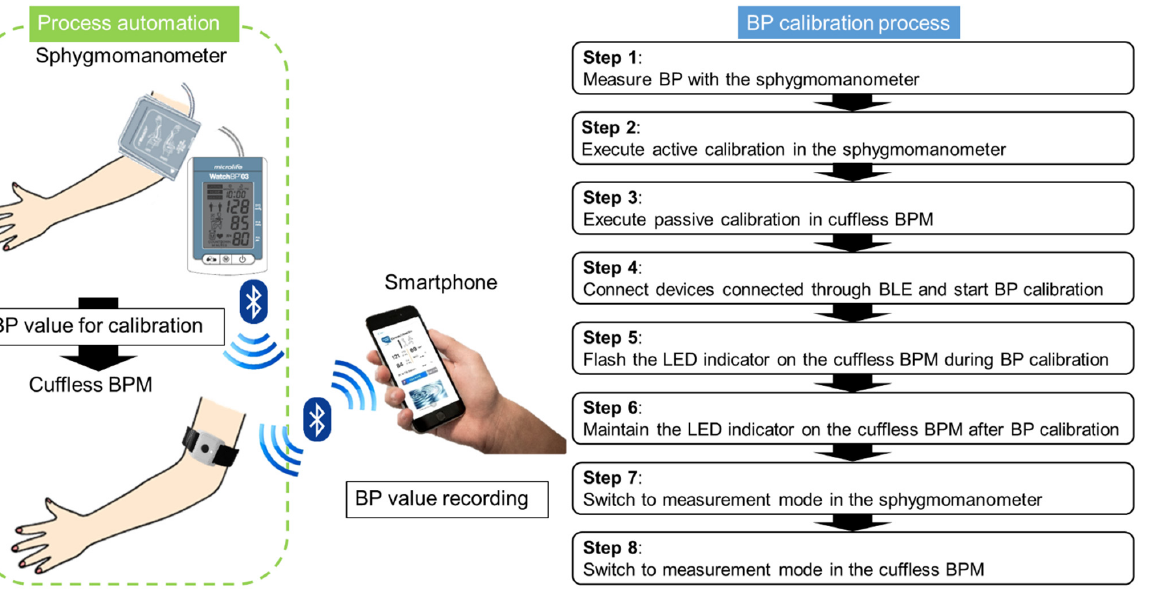
Figure 3. Autocalibration process for the cuffless BP measurement via a cuff-based (sphygmomanometer) monitor. To take the cuffless BP measurement the first time, a user starts to operate a BP cuff with a sphygmomanometer to manually measure BP. Following manual BP measurement, the succeeding procedures of BP calibration are automatically executed by the cuffless BPM.